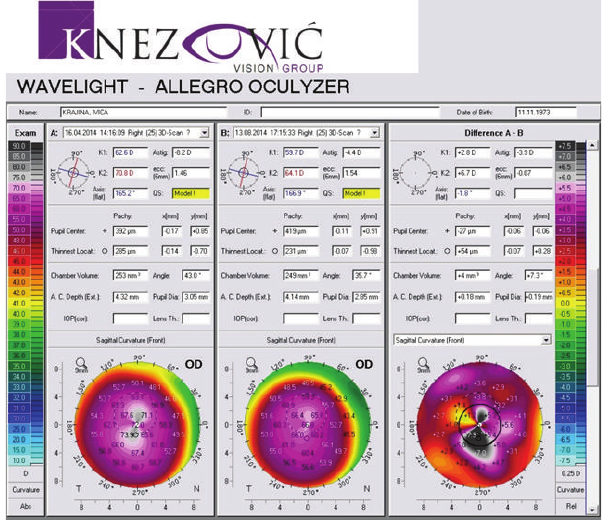
Figure 10: Pre- and postoperative Scheimpflug tomography (ante- rior sagittal curvature map), left eye.